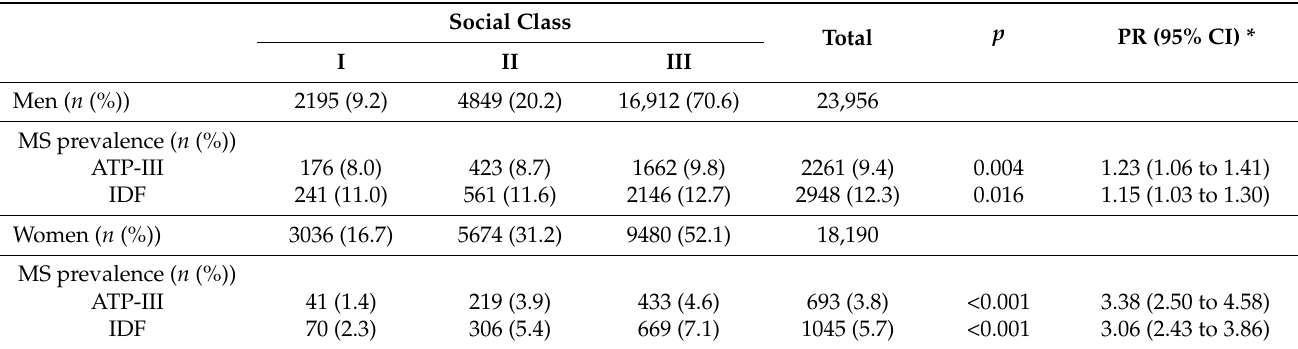
Table 5. PR (95% CI) of MS (ATP-III and IDF criteria) between extreme classes by age groups in men and women. Age Groups (y)